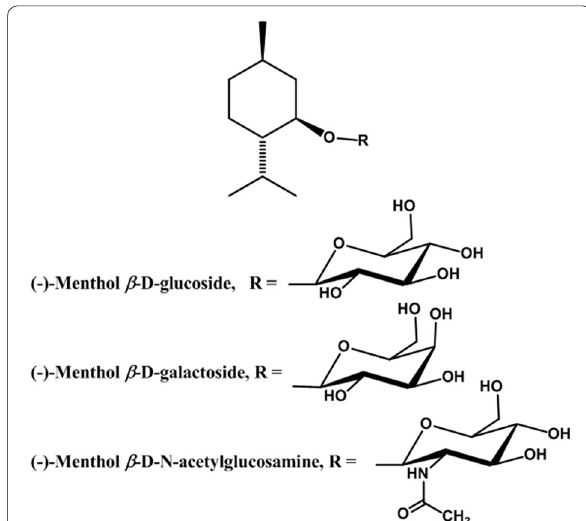
Fig. 1 Structure of ( )‑menthol β‑ d ‑glycosides synthesized by BLC, a − glycosyltransferase from B.